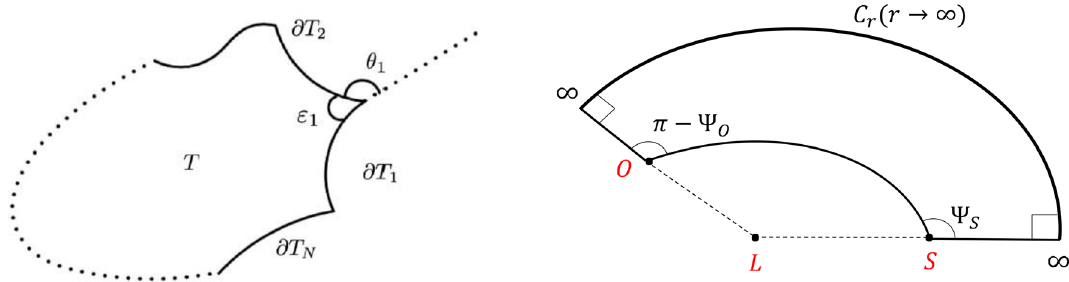
Fig. 8 Left: a schematic for the Gauss-Bonnet theorem [89]. Right: geometrical setup for weak-gravitational lensing. Note that the inner angle at the source and observer are (cid:24) S and π − (cid:24)